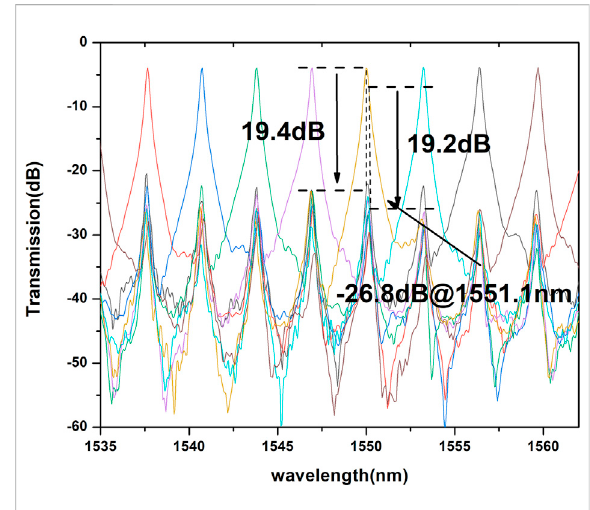
FIGURE 8 Resonance peak shift at different voltages of MRR4 drop channel.